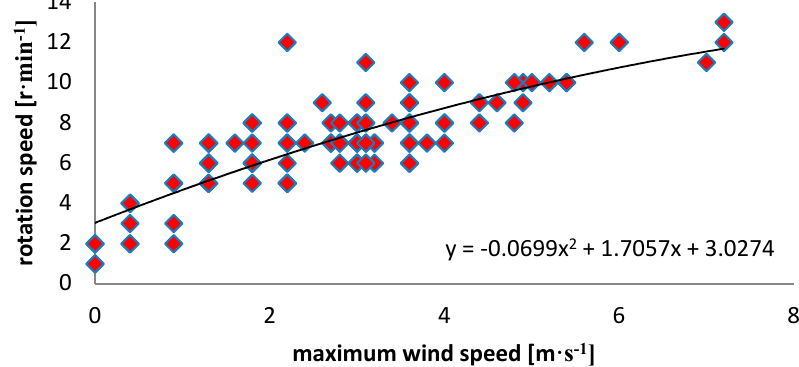
Figure 3. Rotational speed model of the aerator pulverization wheel in relation to wind speed.